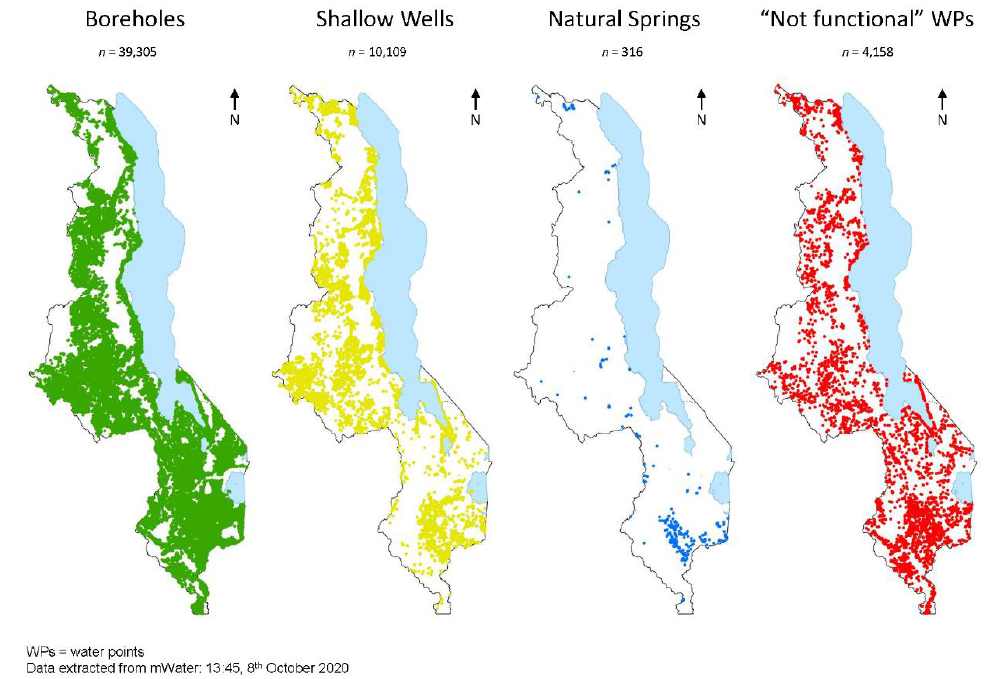
Figure 2. All water points included in this study. Only direct groundwater sources were considered (each water point type is represented separately). The data is representative of the time/date it was extracted from mWater (8 October 2020).